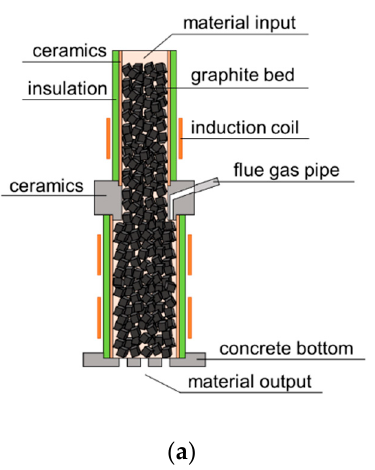
Figure 1. ( a ) Schematic illustration of the so called InduRed reactor and ( b ) said reactor operating at a test series for metal recovery from basic oxygen furnace slag. [29,30].